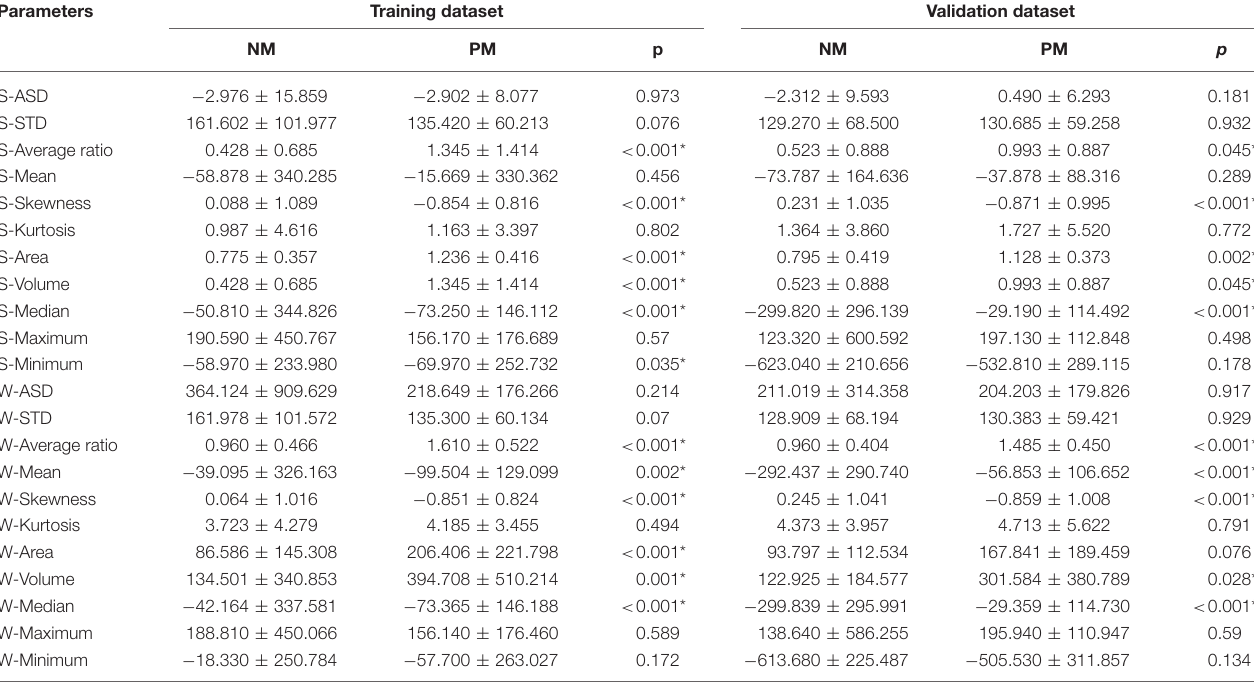
TABLE 2 | Comparison of single-slice and whole-lesion histogram parameters of PM and NM in the training and validation datasets. Parameters